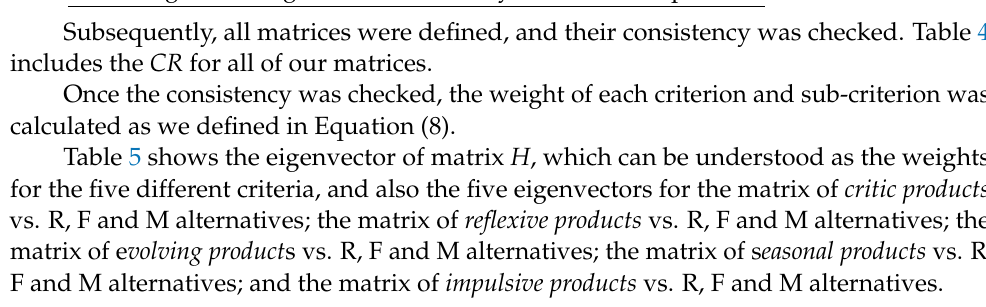
Table 4. Consistency ratio for all pairwise matrices.